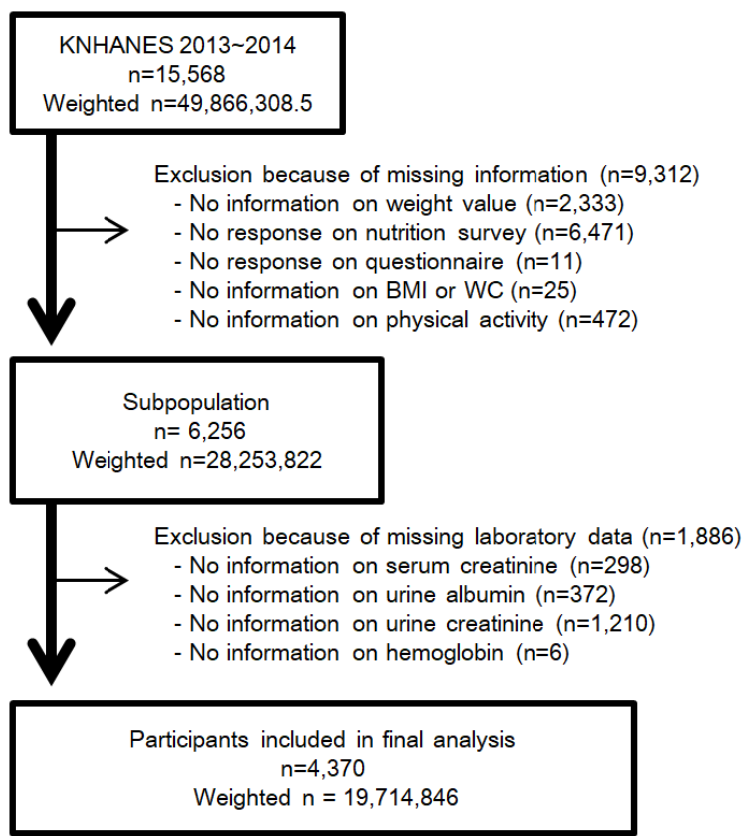
Figure 1. Flow diagram for determining study population with the exclusion and inclusion criteria. Abbreviation: KNHANES, Korean National Health and Nutrition Experimental Survey; n , unweighted number of participants; weighted n , weighted number of participants using complex samples design; BMI, body mass index; WC, waist circumference.